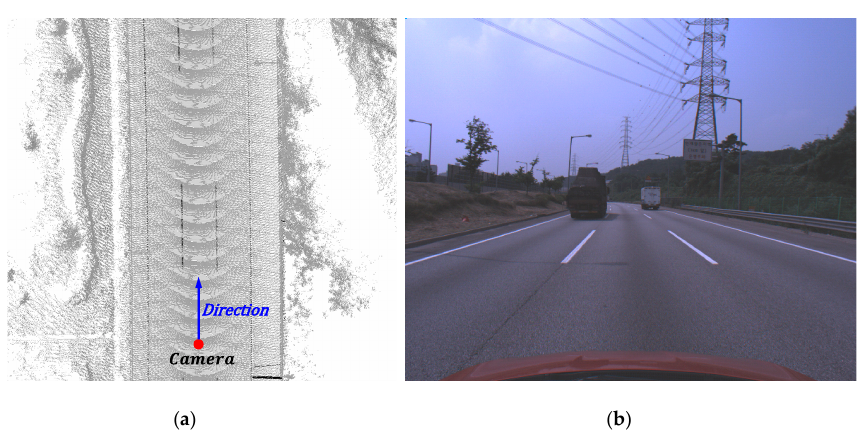
Figure 8. Example 3D structure and image captured by MMS and camera. ( a ) 3D structure obtained by the MMS; ( b ) Image captured by the camera. A red point and blue arrow in ( a ) indicate the camera position at the time when the image ( b ) was captured.